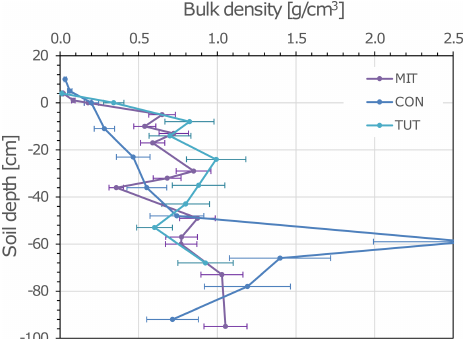
Figure 1. Depth profile of soil bulk density (mass fine earth per volume fine earth) of the three experimental sites: Mitterfels (MIT), Conventwald (CON) and Tuttlingen (TUT). Due to the high stone contents of the soils, the “quantitative soil pit” (QP) as described in (Lang et al., 2017) was used to determine bulk densities. Error bars represent standard deviation calculated based on the average coef- ficient of variance of the method determined at the corresponding study